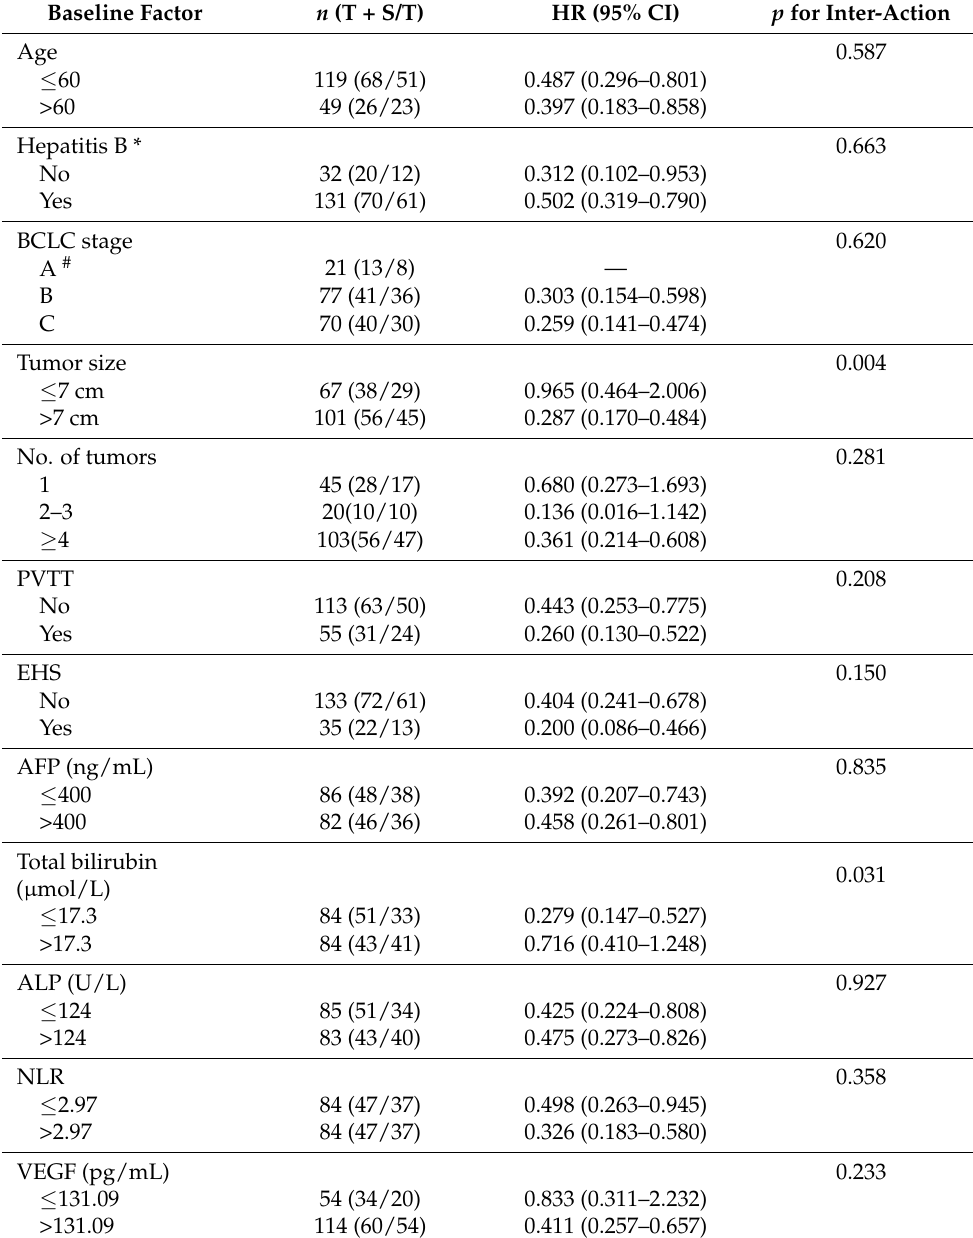
Table 4. VEGF and other clinical variables for predicting sorafenib-related survival